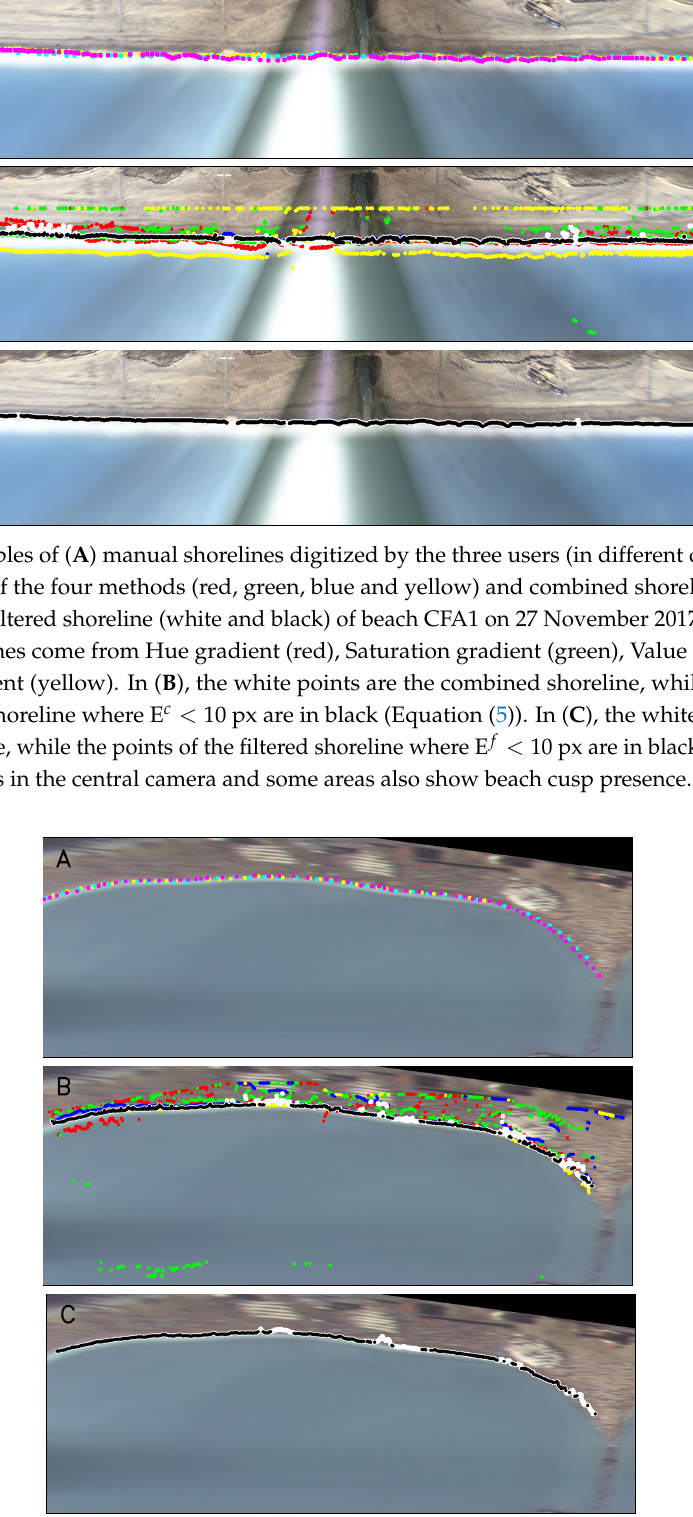
Figure 4. Equivalent to Figure 3, but of beach BCN1 on 15 July 2017 at 12 h. This planview shows an example of high beach